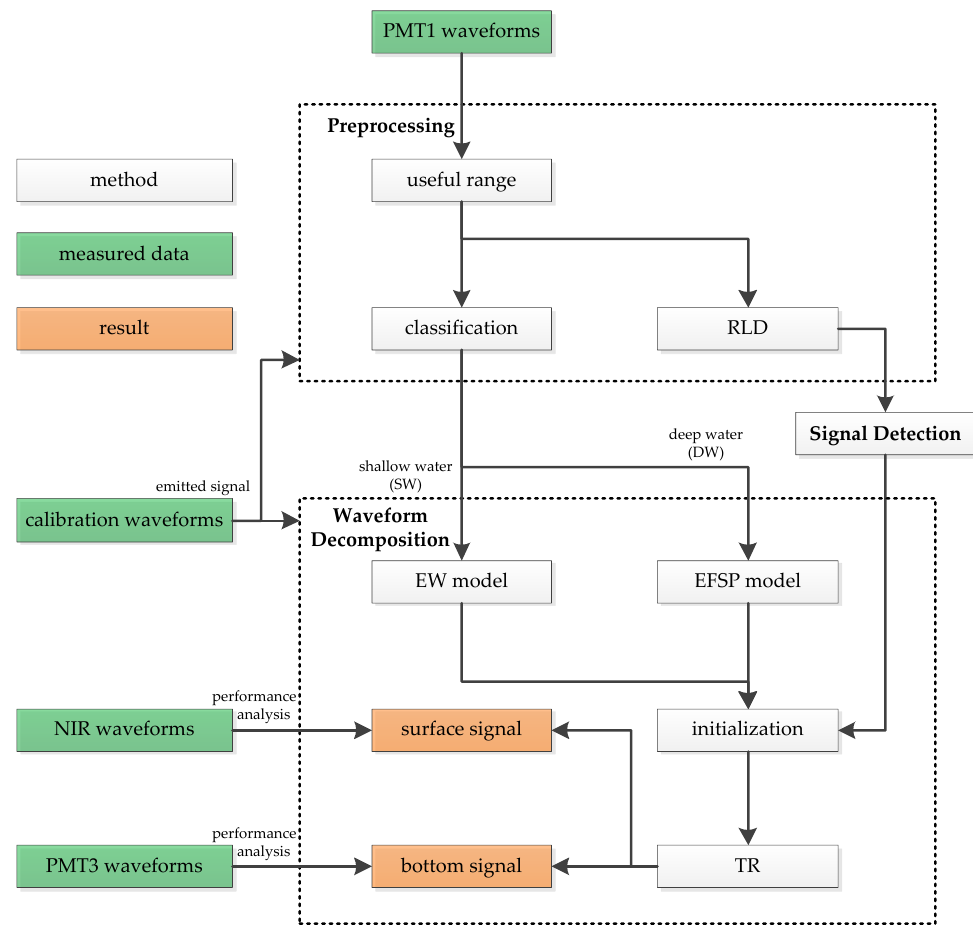
Figure 2. Workflow of the depth-adaptive waveform decomposition method. PMT: photomultiplier tube; RLD: Richardson–Lucy deconvolution; EFSP: exponential function with second-order polynomial model; EW: empirical waveform model; NIR: near-infrared; TR: trust region algorithm.